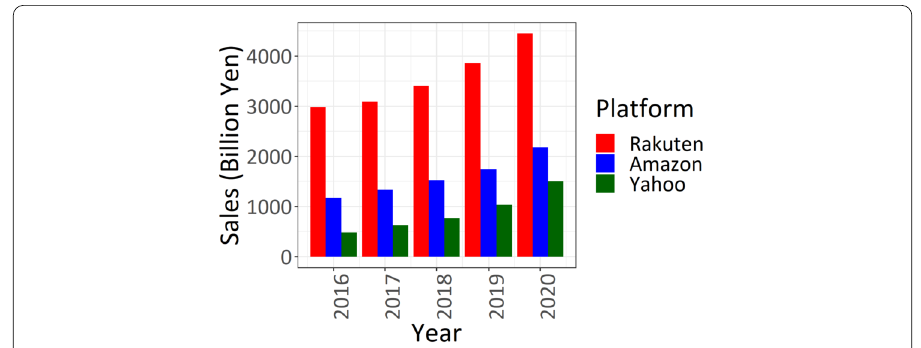
Figure 1 Annual Sales of the Top Three Online Platforms. The top three online platforms in Japan are Rakuten Group, Inc., Amazon Japan G.K., and Z Holdings (the parent company of Yahoo! Japan). We used all of the Amazon Japan sales since Amazon Japan does not publish online shopping sales alone. Data source: